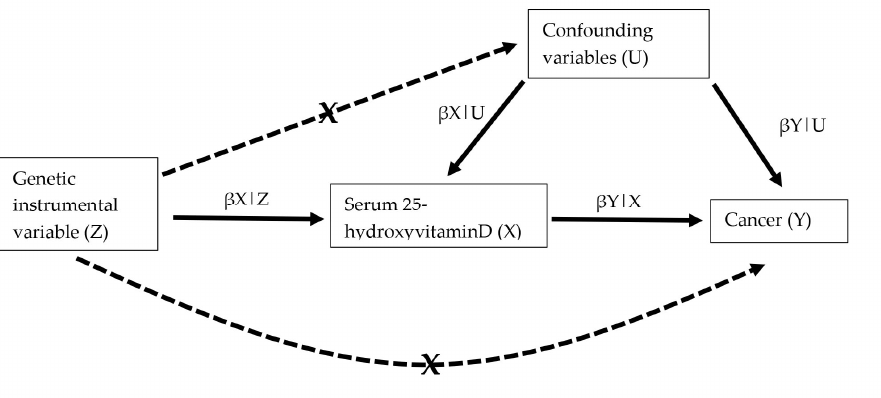
Figure 1. Overview of assumptions for Mendelian randomization (MR) studies.